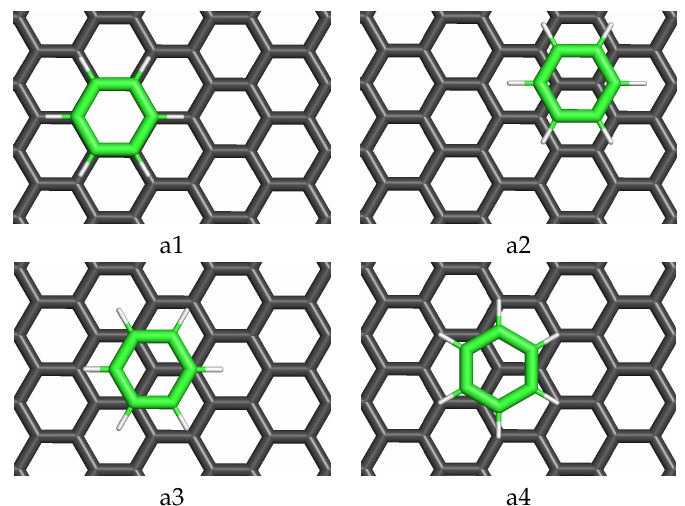
Figure 1. Four configurations for an isolated benzene molecule deposited on graphene ( a1 – a4 ). The atoms are depicted with sticks and the color labels are dark grey for C atoms of the graphene layer, green for C atoms of the benzene molecule and white for H atoms.